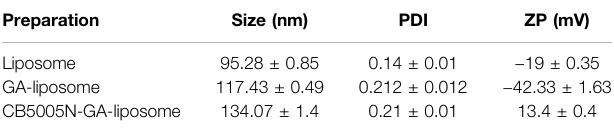
TABLE 2 | Mean particle size, PDI and zeta potential of Blank-liposome, GA- liposome and CB5005N-GA-liposome (Mean ± SD, n = 3). Preparation